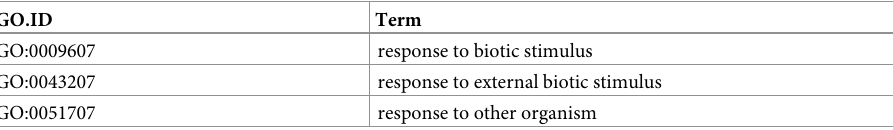
Table 5. BP GO terms shared between LN/L6 and L6L1/L6H1